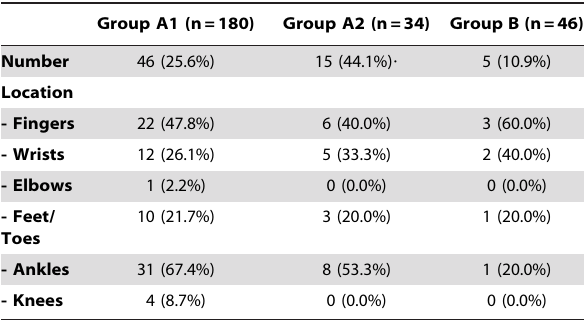
Table 4. Periarticular